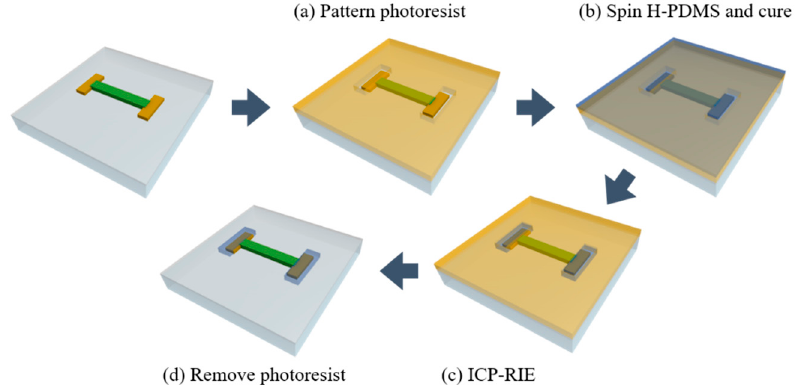
Figure 2. The process of patterning the H-PDMS: ( a ) photoresist as an etching mask; ( b ) formation of H-PDMS; ( c ) etching the top of H-PDMS to expose photoresist surface; ( d ) remained H-PDMS as the buffer layer.